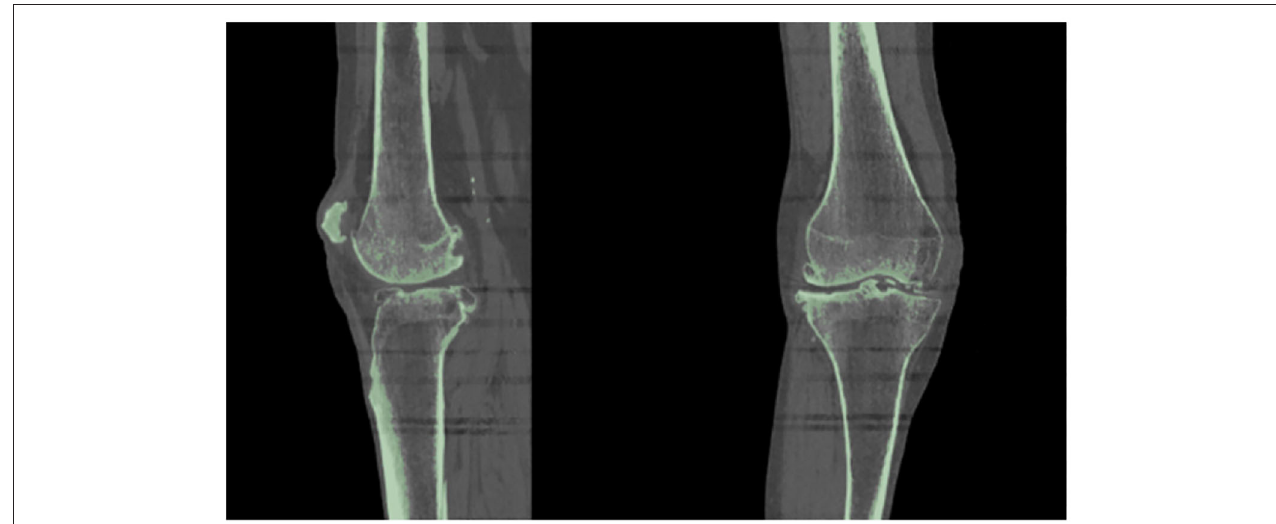
FIGURE 2 | Results obtained using 3D Slicer’s “Threshold” algorithm. Since the bones have the same intensity in the CT image, the software corresponds one label (indicated with green color) to all the pixels representing the patient’s knee bones.